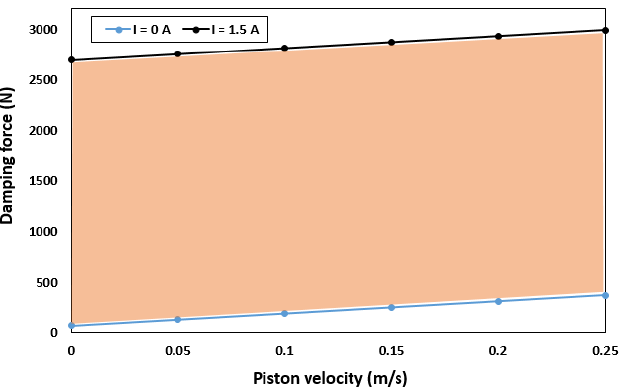
Figure 5. Variation of damping force of the HARMRD with piston velocity for initial design values.